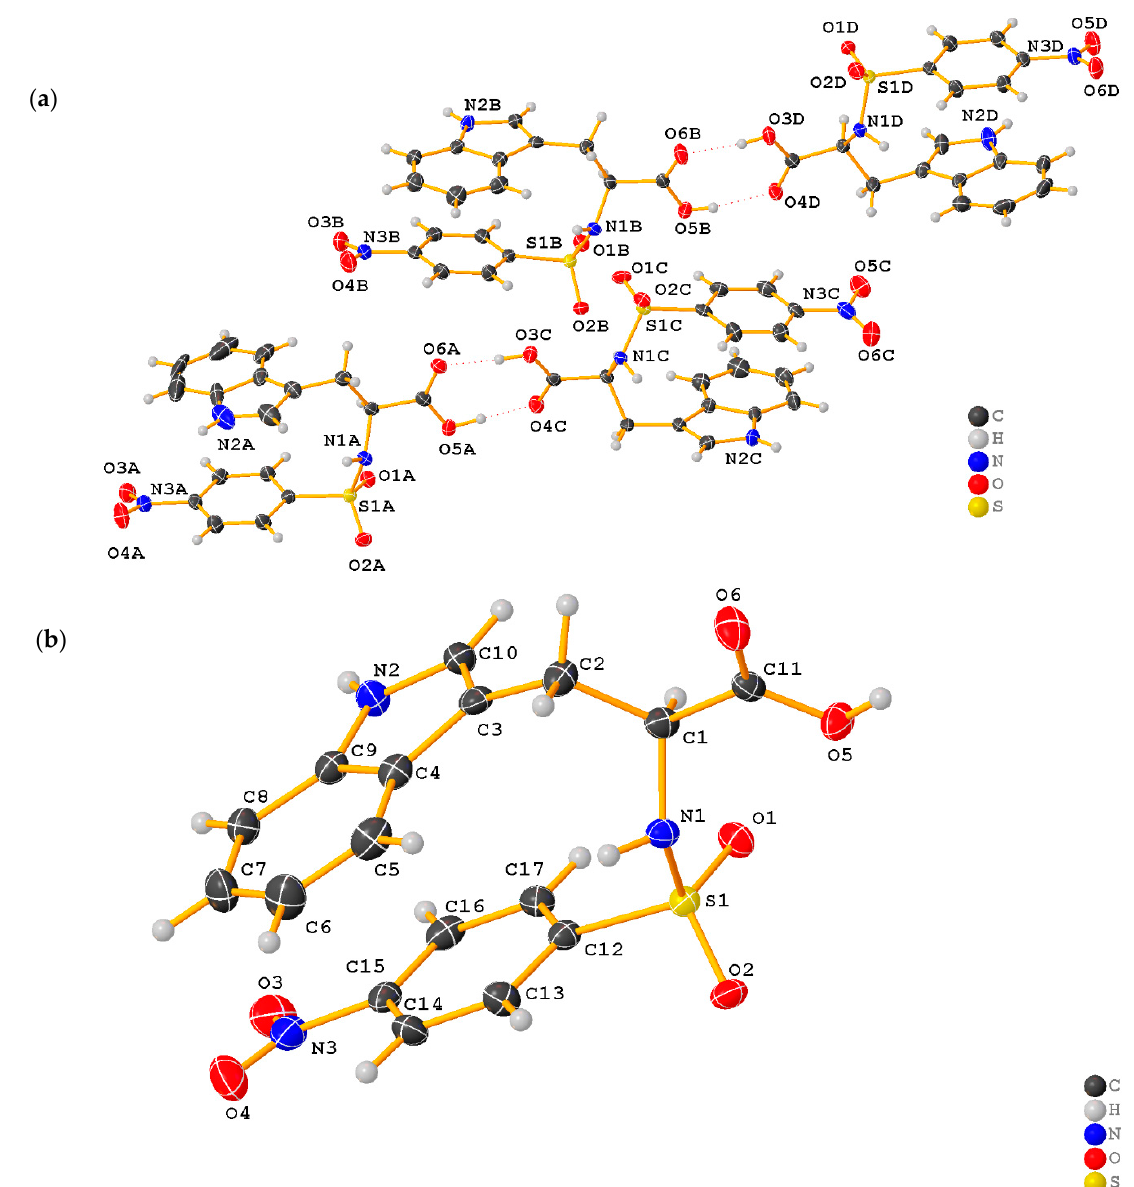
Figure 2. ( a ) Crystal structure of ((4-nitrophenyl)sulfonyl)tryptophan (DNSPA) showing four inde- pendent molecules in the asymmetric unit connected by C-H ··· O intermolecular hydrogen bond. ( b ) Molecular structure of one molecule of DNSPA. Ellipsoids are drawn at 50% probability. The sulfonamide S1-N1 bond length of 1.624(3) Å, is slightly shorter than the expected average N-S bond length (1.771(4) Å) [51,52], probably due to the influence of the elec- tronegative oxygen atoms on the S1 atom resulting in a decrease in the N1-S1 bond length. The N3-C15 bond length of the p-nitro substituent of 1.473(4) Å is longer than the N2-C10 (1.356(7) Å) and N2-C9 (1.358(8) Å) bonds of the aromatic indole ring. The